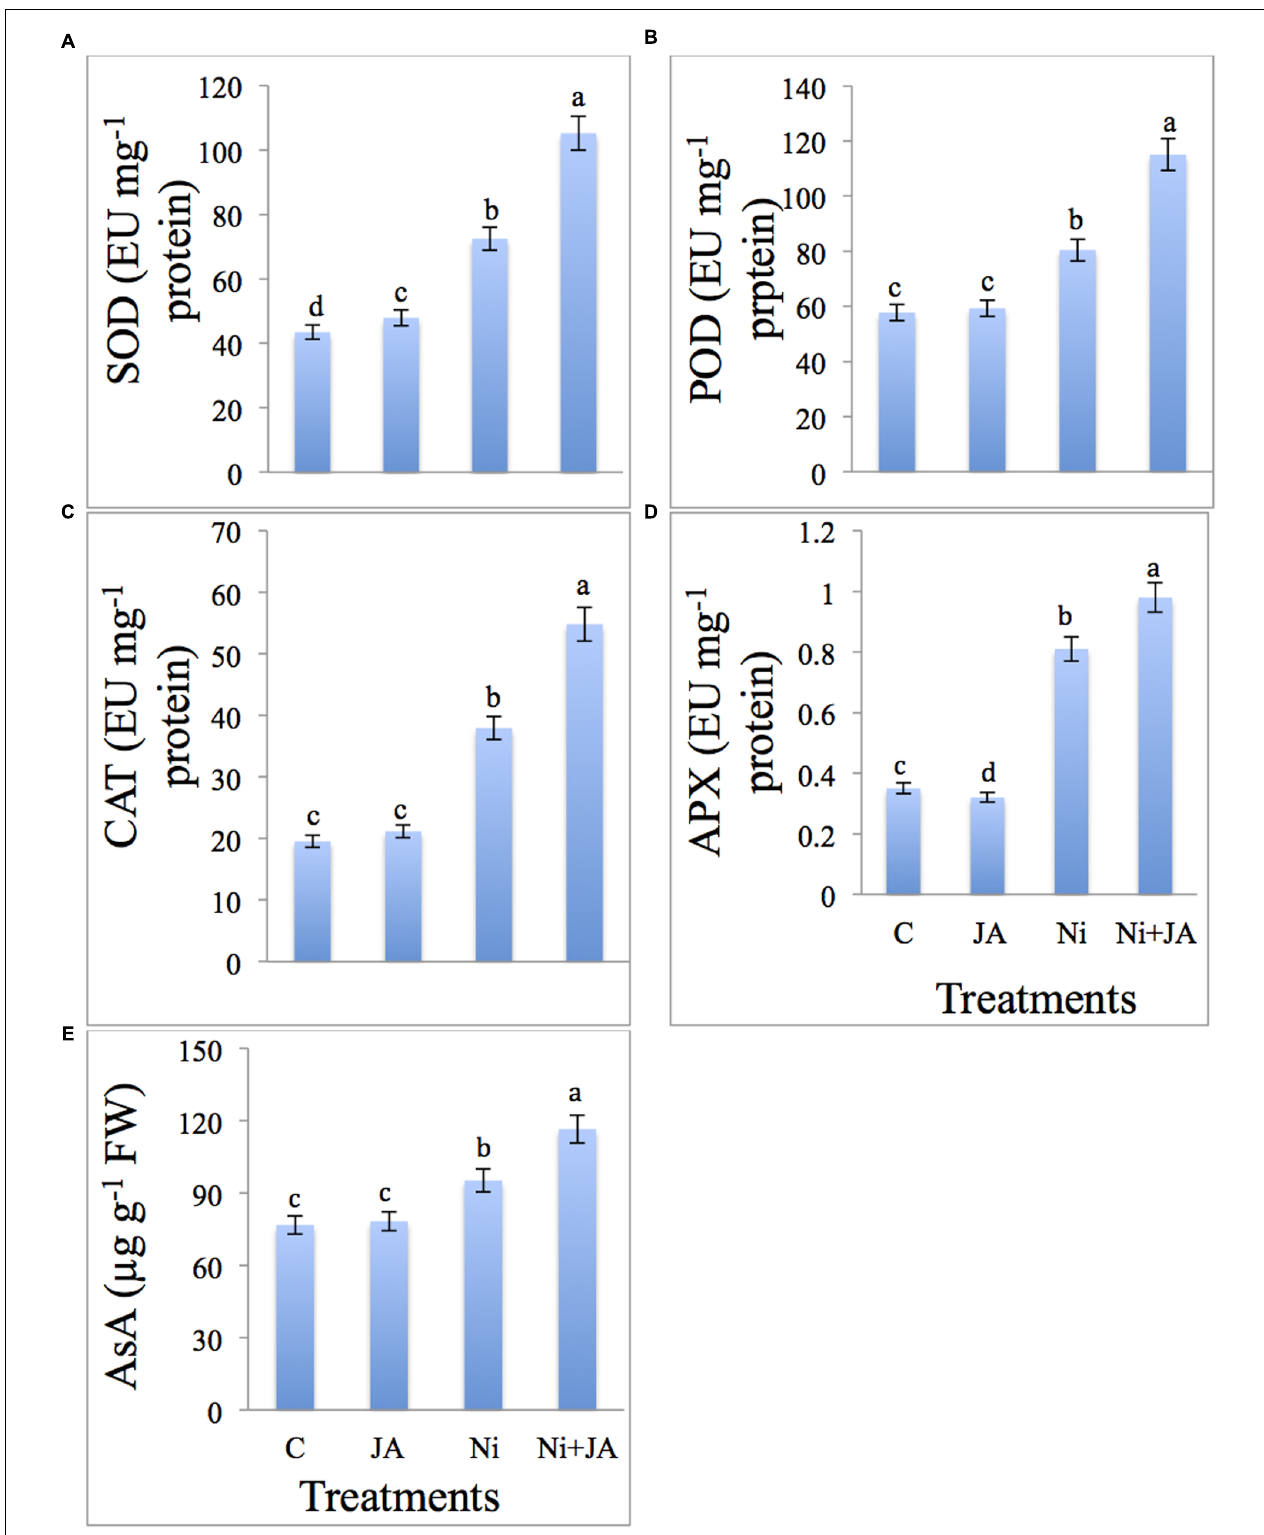
FIGURE 3 | Effect of Ni and JA individually and in combination on (A) SOD, (B) POD, (C) CAT, (D) APX, and (E) AsA in soybean seedlings. Different letters indicate significant difference between means at p ≤ 0.05 (DMRT). Values are means ± SE ( n = 5).